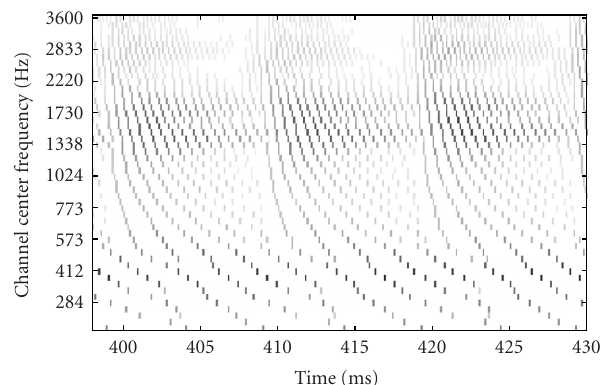
Figure 5: Auditory representation (here with 50 channels) of the sound [I] taken from “there is,” spoken by a male. Peaks are shown as rectangles with their intensity representing their amplitude. The time axis covers three pitch